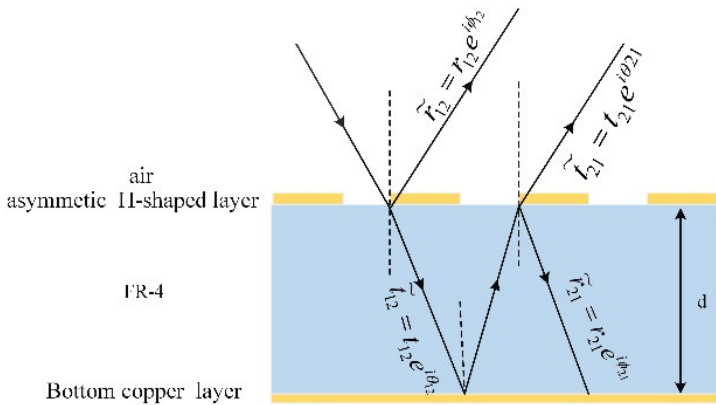
Figure 7. Multiple reflection and interference theory model of the metamaterial absorber.